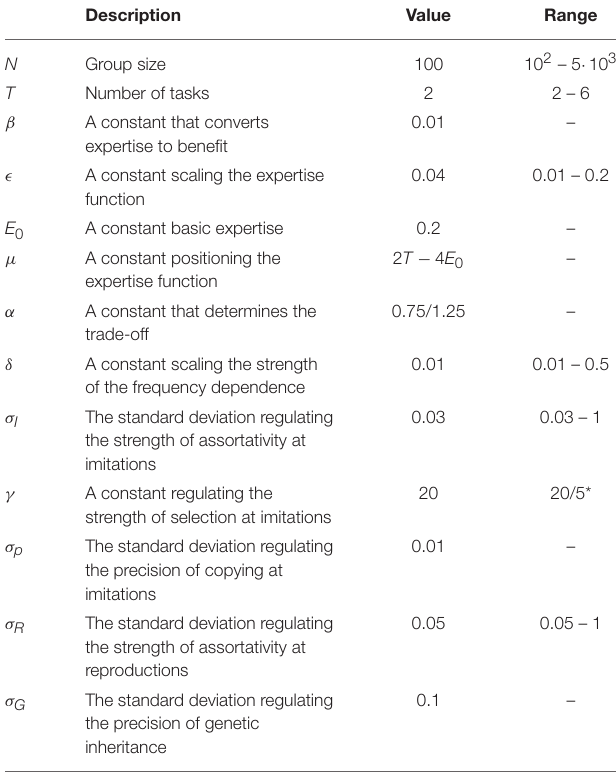
TABLE 1 | Parameters of the